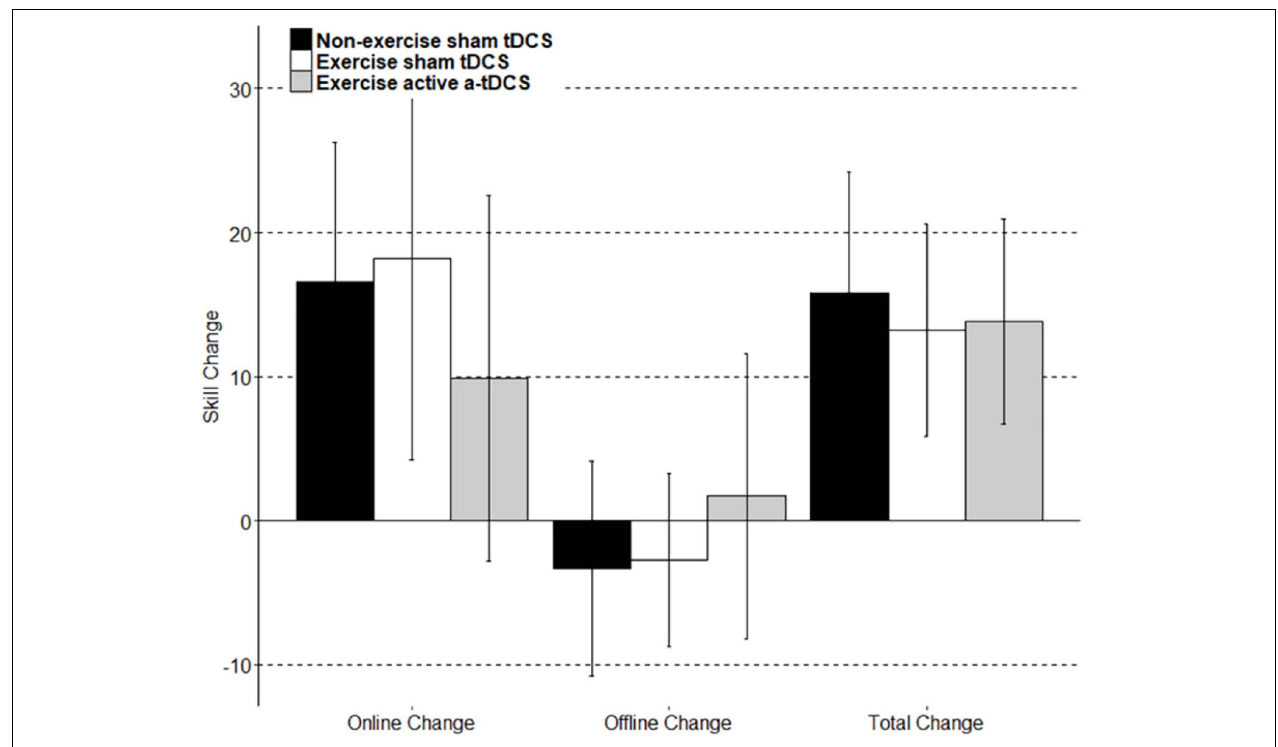
FIGURE 5 | A visual representation of the group mean skill change score of subcomponents. Online change: the sum of difference of scores between only the last block and first block of each intervention session. Offline change: the sum of scores from the differences between only the first block of day two and the last block of day 1, and the first block of day three and the last block of day two. Total change: the sum of online change, offline change, the difference between the first block of retention and the last block of day 3, and the difference between the final retention block and the first retention